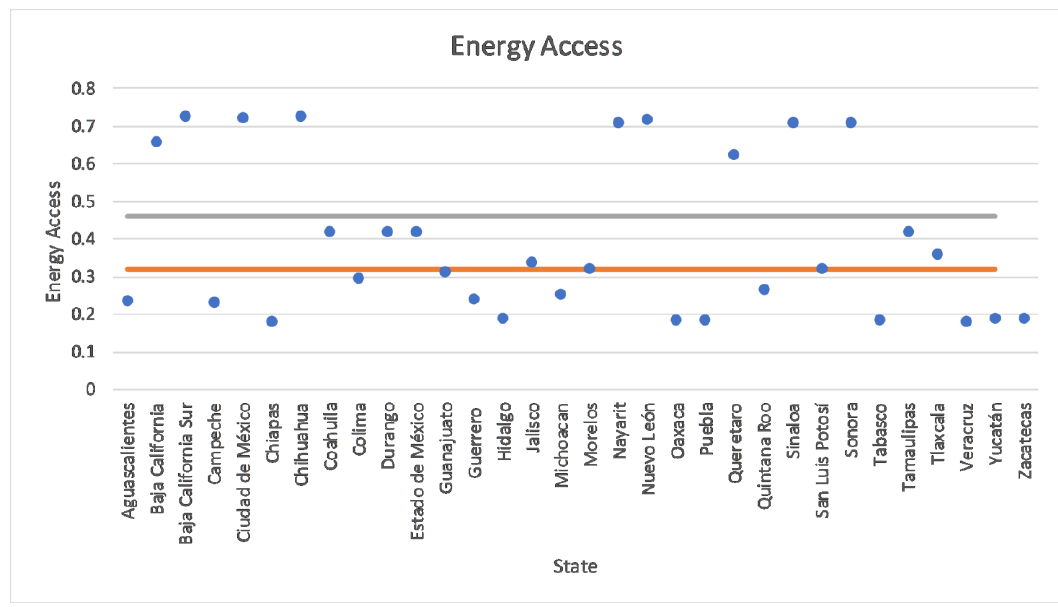
Figure 9. Energy access by state. Less than 0.32 is considered as low energy access, greater than 0.46 is considered as high energy access. Between 0.32 and 0.46 is considered as medium energy access.